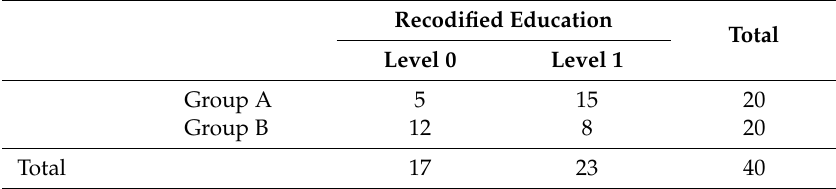
Table 5. Recodified educational level. Distribution by groups.